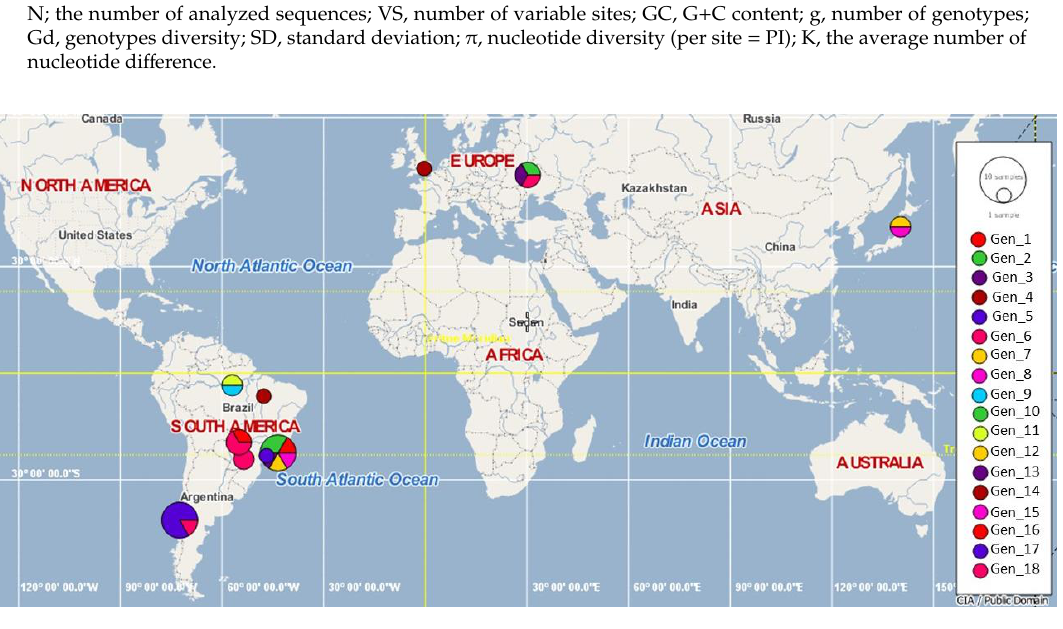
Figure 3. Geographic distribution of hemoplasmas 16S rDNA genotypes in rodents worldwide, including the two genotypes (#17 and #18) found in the present study, in the Valdivia province, Southern Chile.